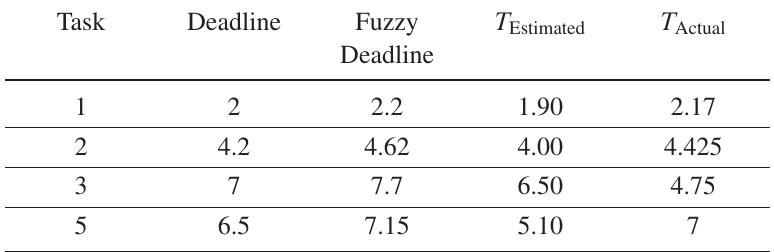
Table 3. Soft and hard deadlines and actual task completion